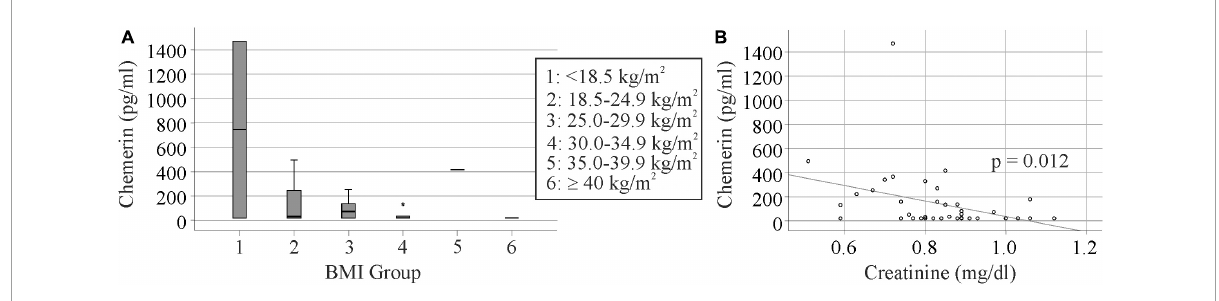
FIGURE4 Urinary chemerin levels in relation to BMI and serum creatinine. (A) Urinary chemerin stratified for BMI. The asterisk marks an outlier (three box lengths from the median). (B) Correlation of urinary chemerin with serum creatinine.